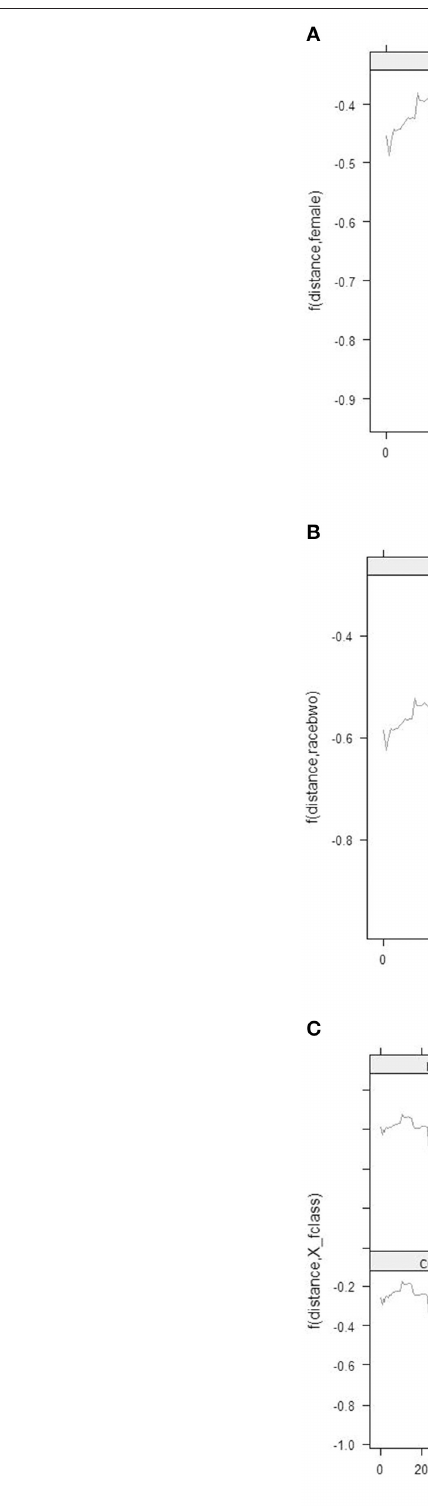
Frontiers in Public Health |